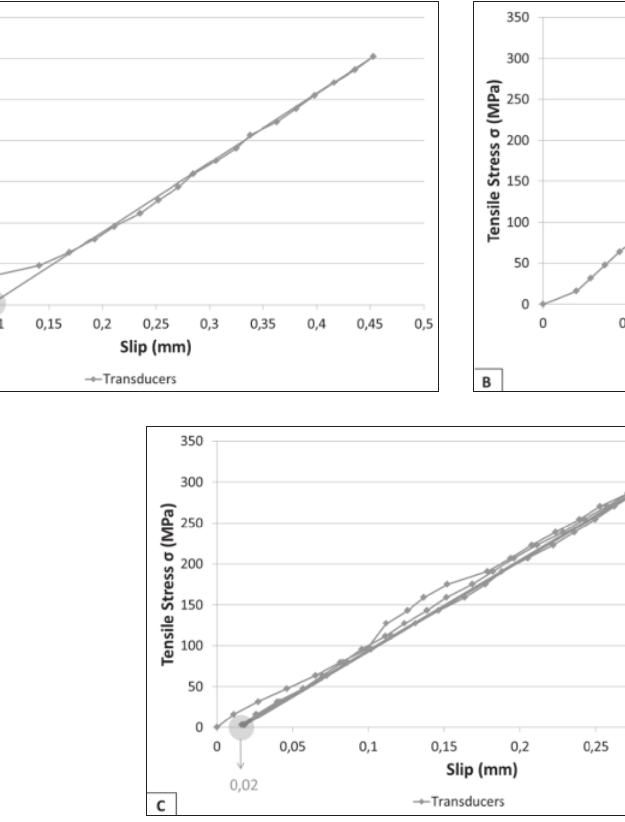
Figure 19 Evolution of the relative slip between bar and mechanical splice type RC-20mm. A - Method 1, B - Method 2 and C - Method